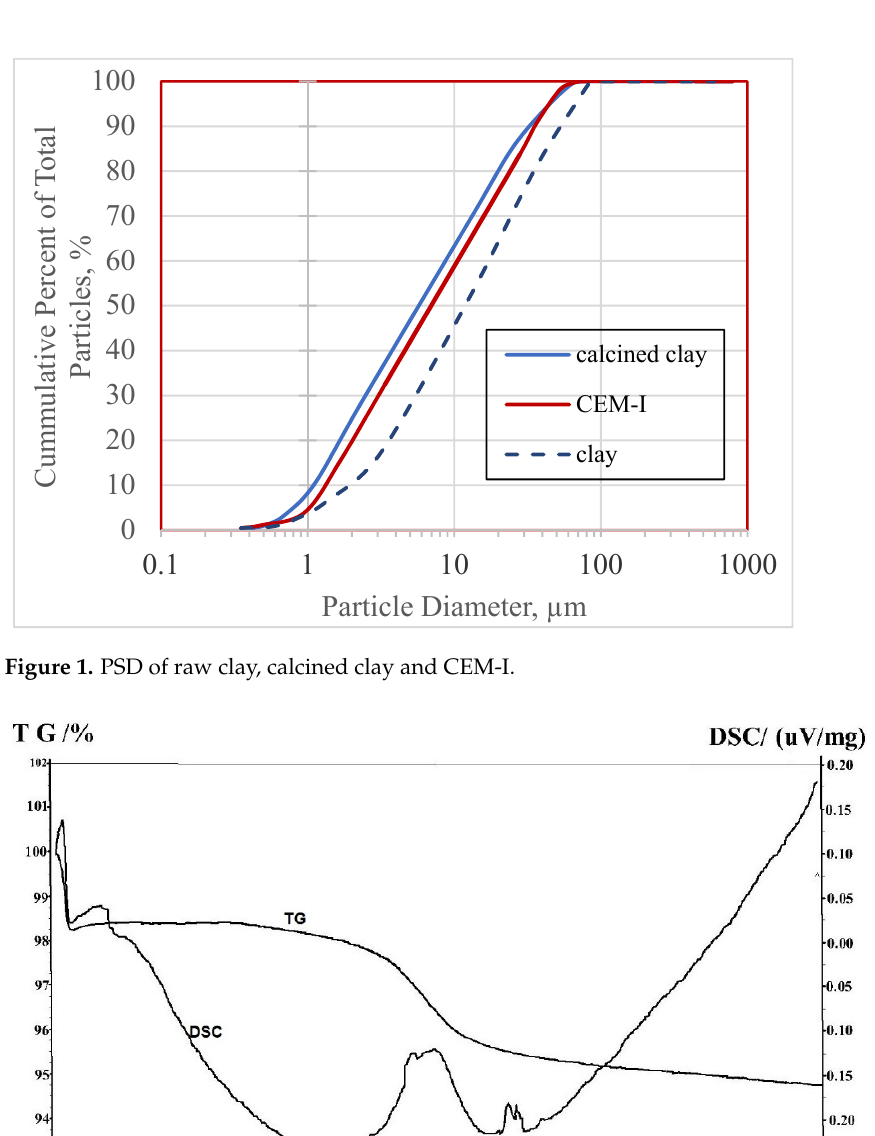
Figure 1. PSD of raw clay, calcined clay and CEM-I.